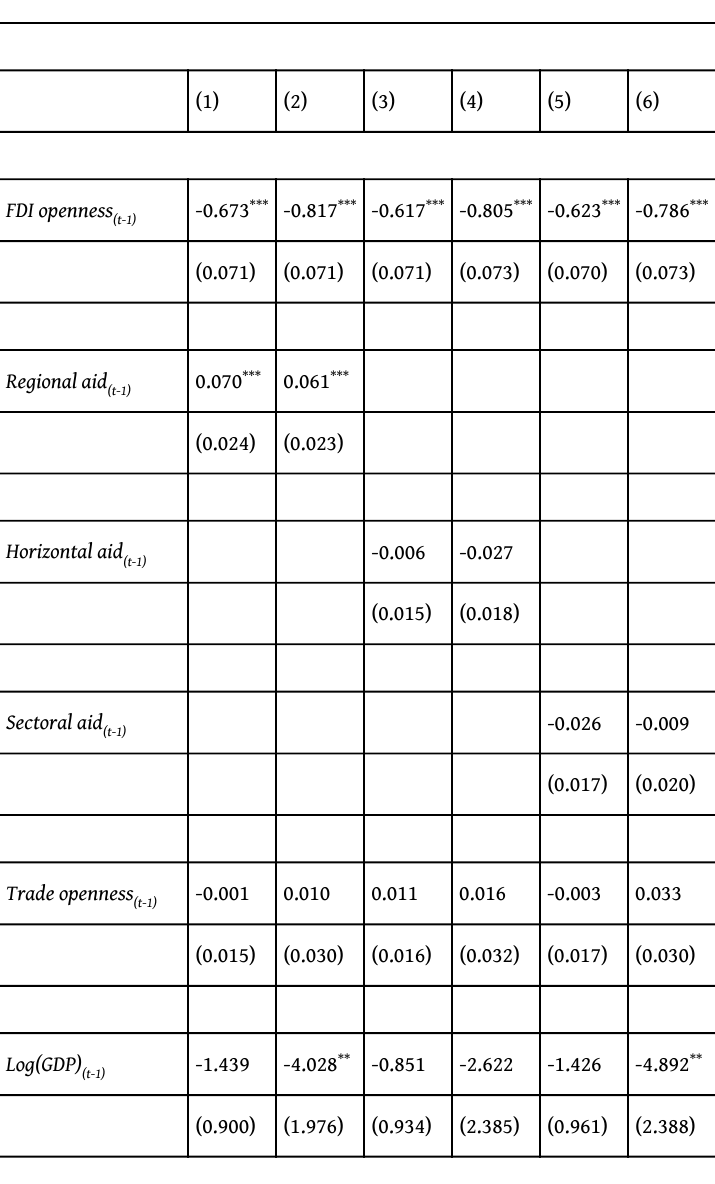
Table 2: ECM on the effect of aid allocations on FDI openness